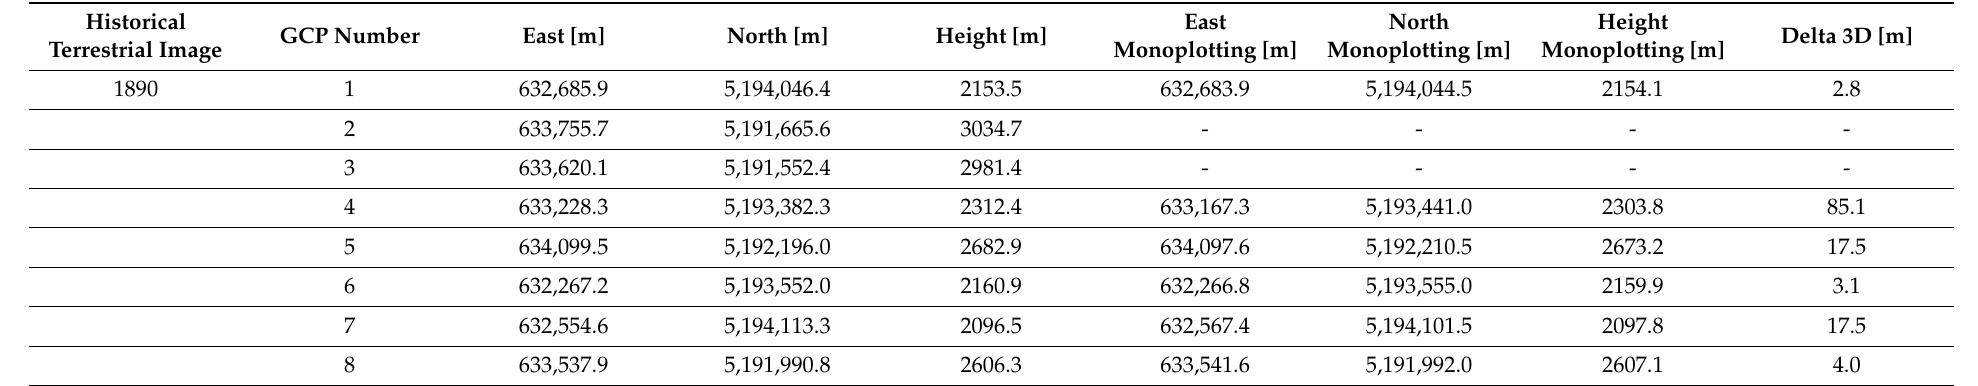
Table A3. Monoplotting accuracy of 1890 and 1907 photos: Coordinates of the user defined GCPs (East, North and Height), by monoplotting calculated GCPs (East monoplotting, North monoplotting and Height monoplotting) and corresponding Euclidean distance as error value (Delta 3D). In two cases, no coordinates could